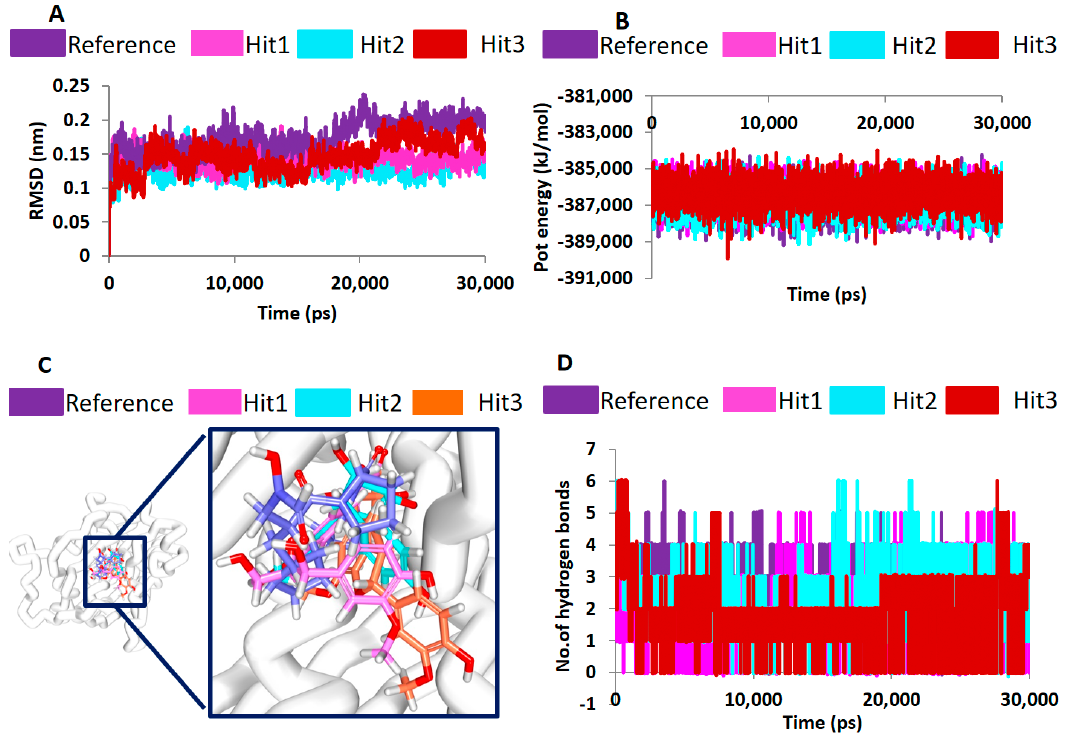
Figure 6. Molecular dynamics simulation results. ( A ) Stability assessment by root mean square deviation. ( B ) Stability assessment by potential energy profiles. Both the graphs demonstrate that the systems were highly stable through a 30-ns run. ( C ) Evaluation of the binding modes ( D ) Enumeration of stable H-bond interactions during 30-ns run.